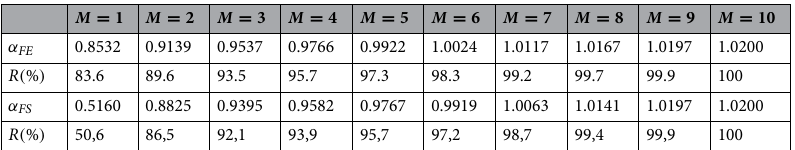
Table 6. Comparison of activity scores for feature extraction and activity scores for feature